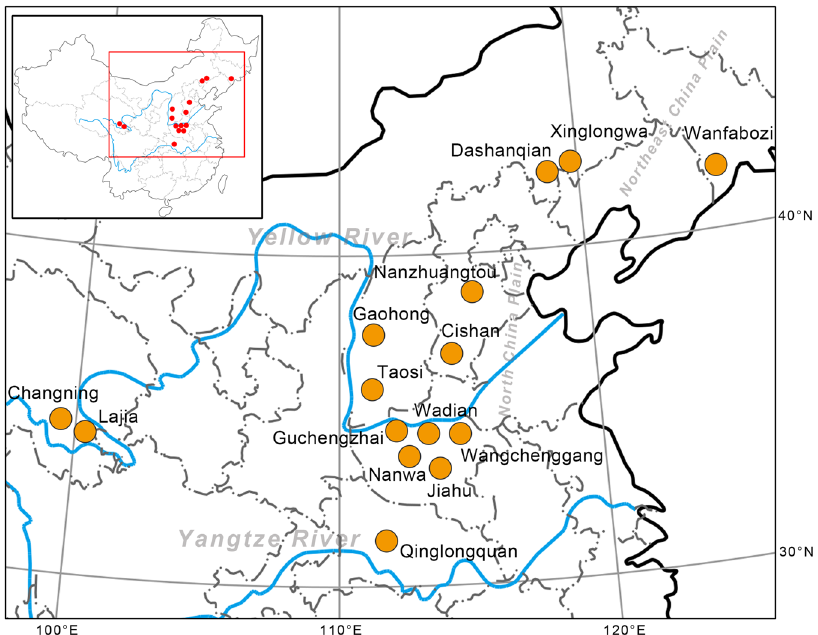
Figure 1. Locations of samples. The orange dots depict all sites from which we retrieved ancient pig sequences. The inset shows the location of the region within China. The maps are modified from free map materials deposited in the public database of National Administration of Surveying, Mapping and Geoinformation